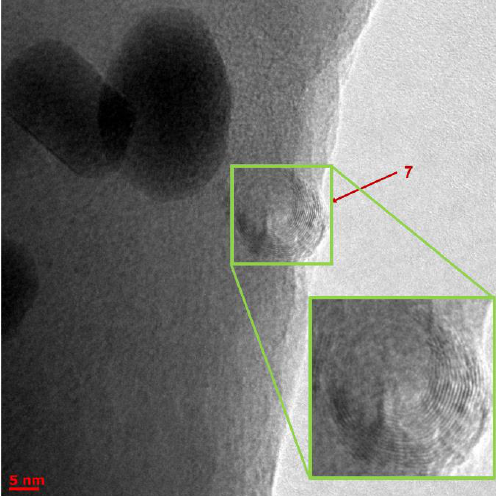
Figure 14. TEM image of Object 7 is a multilayer nanotube with 16 layers. The distance between the layers is 2.4 Å, and the distance between neighboring atoms is about 3.2–3.6 Å. The total diameter of the object is 10 nm.